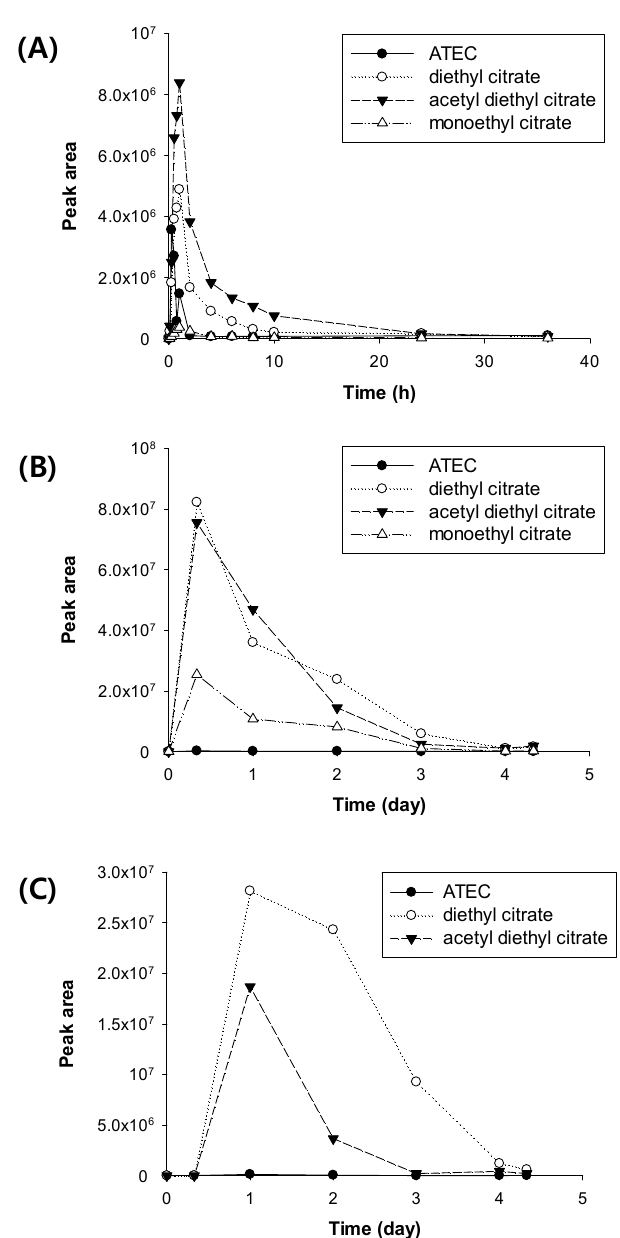
Figure 6. Plot of time–peak area for ATEC and its metabolites in ( A ) plasma, ( B ) urine, and ( C ) feces from the rats orally administered ATEC.